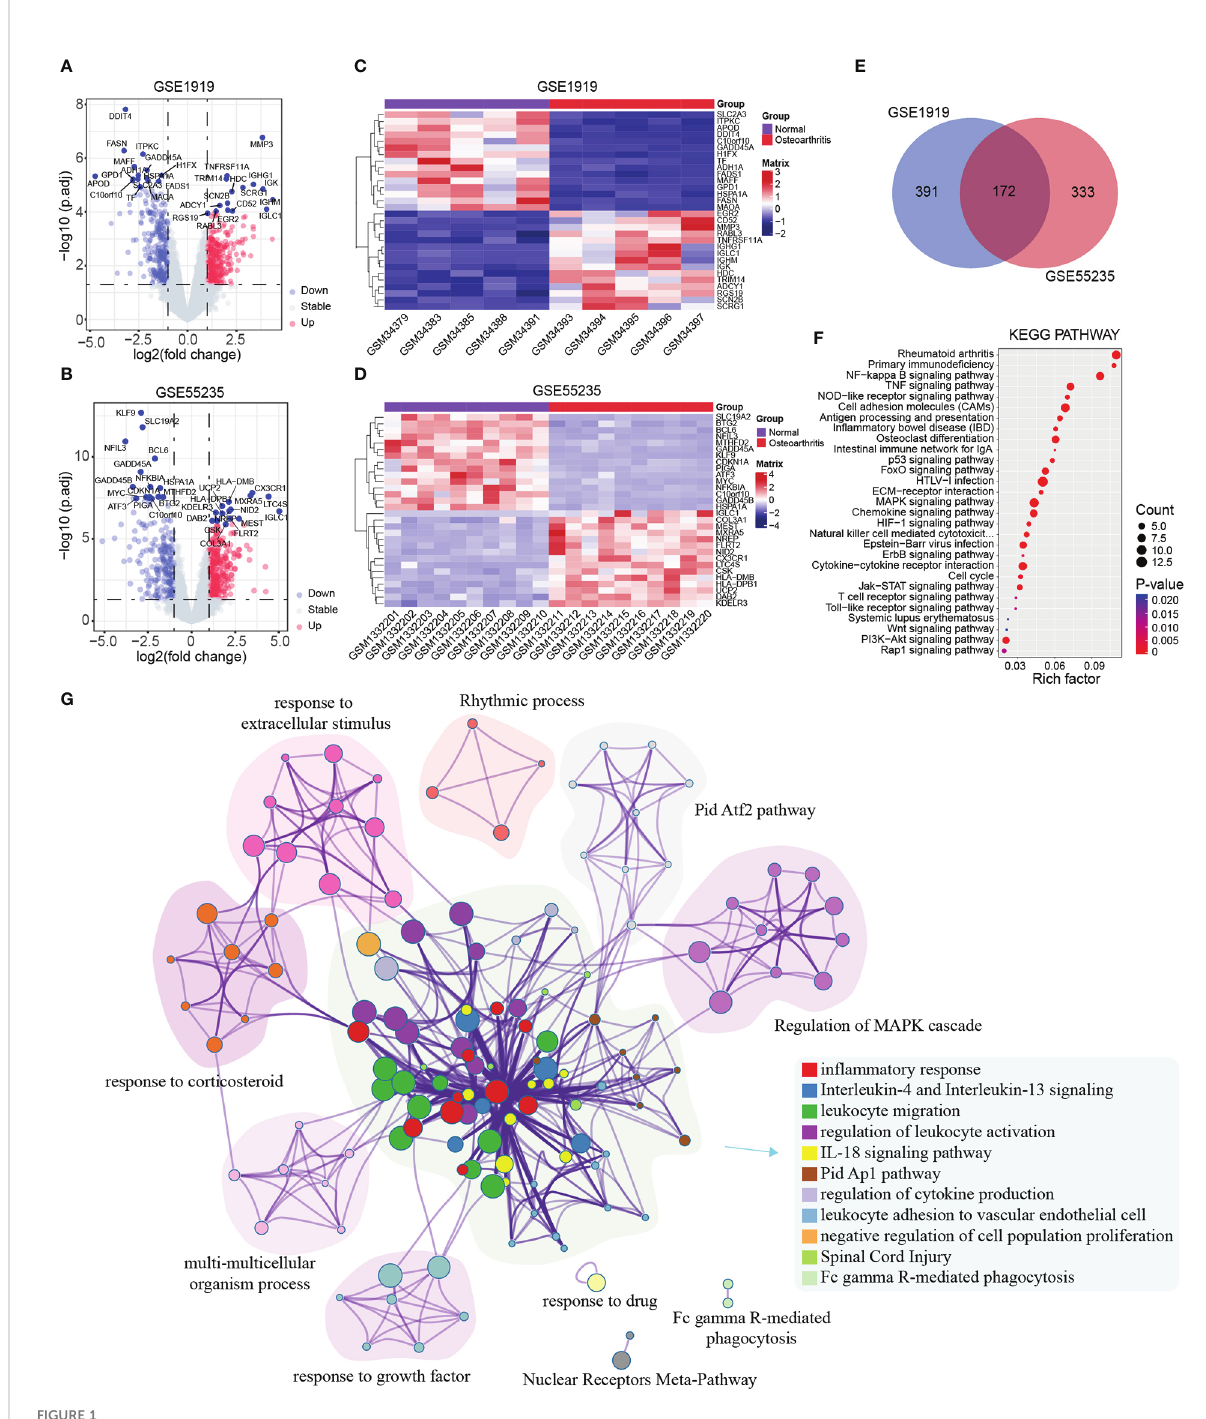
FIGURE 1 Differential expression genes and function analysis. (A, B) Volcano plot showed DEGs in GSE1919 and GSE55235, respectively. Blue dots represented downregulated DEGs, red dots represented upregulated DEGs, and gray dots represented the rest of the no signi fi cant differential expressed. (C, D) Heatmap showed the potential top 15 DEGs in GSE1919 and GSE55235, respectively. (E) Venn plot of the common DEGs of GSE1919 and GSE55235. (F) KEGG function analysis of the 172 DEGs. (G) Metascape function clustering analysis of the 172